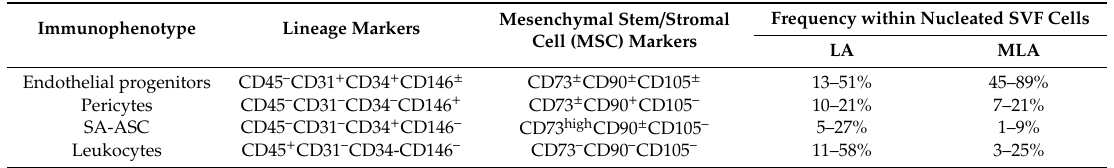
Figure 4. Cell viability in CD45 – and CD45 + SVF cells obtained from SVF-LA or its SVF-MLA counterpart. Table 1. Summarized results of the determined immunophenotypes and their frequency within nucleated SVF cells for the three progenitor populations and